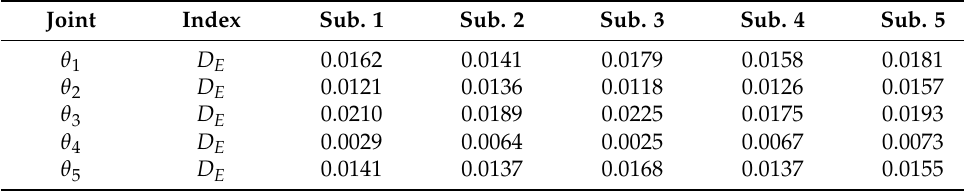
Table 5. Evaluation and comparison of experimental